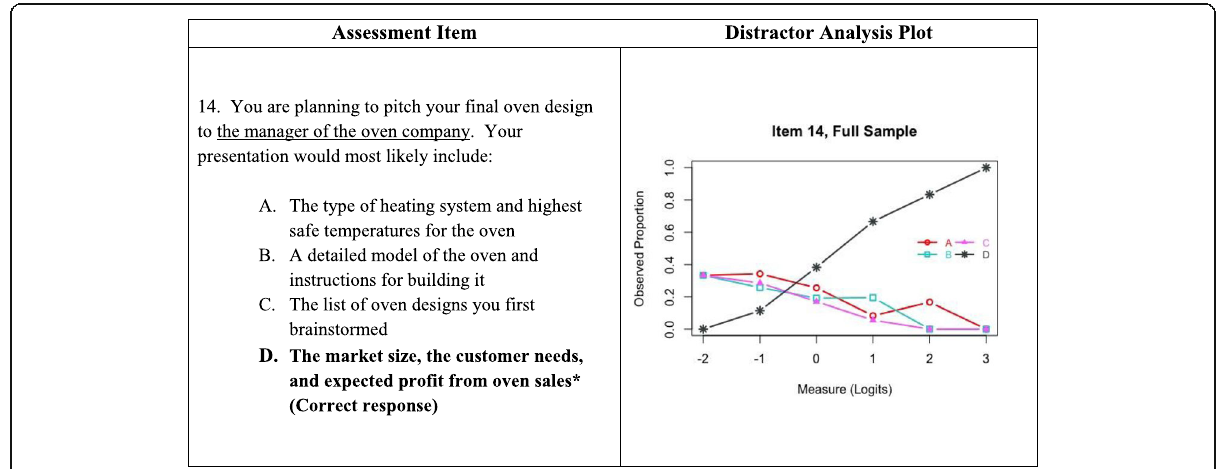
Fig. 4 Distractor analysis plot for item 14: full sample. The plot shows patterns of student answer choices for item 14 within the entire sample. The x -axis displays estimates of student achievement. Student achievement estimates are shown in logits, and these estimates were calculated using the Rasch model. Low values indicate lower achievement, and high values indicate higher achievement. The y -axis shows the observed proportion of responses for a given answer choice. The lines in the plot show the proportion of students who selected each of the four answer choices (A, B, C, or D) at each level of achievement. For this item, the correct response is D (black line with asterisk plotting symbols)